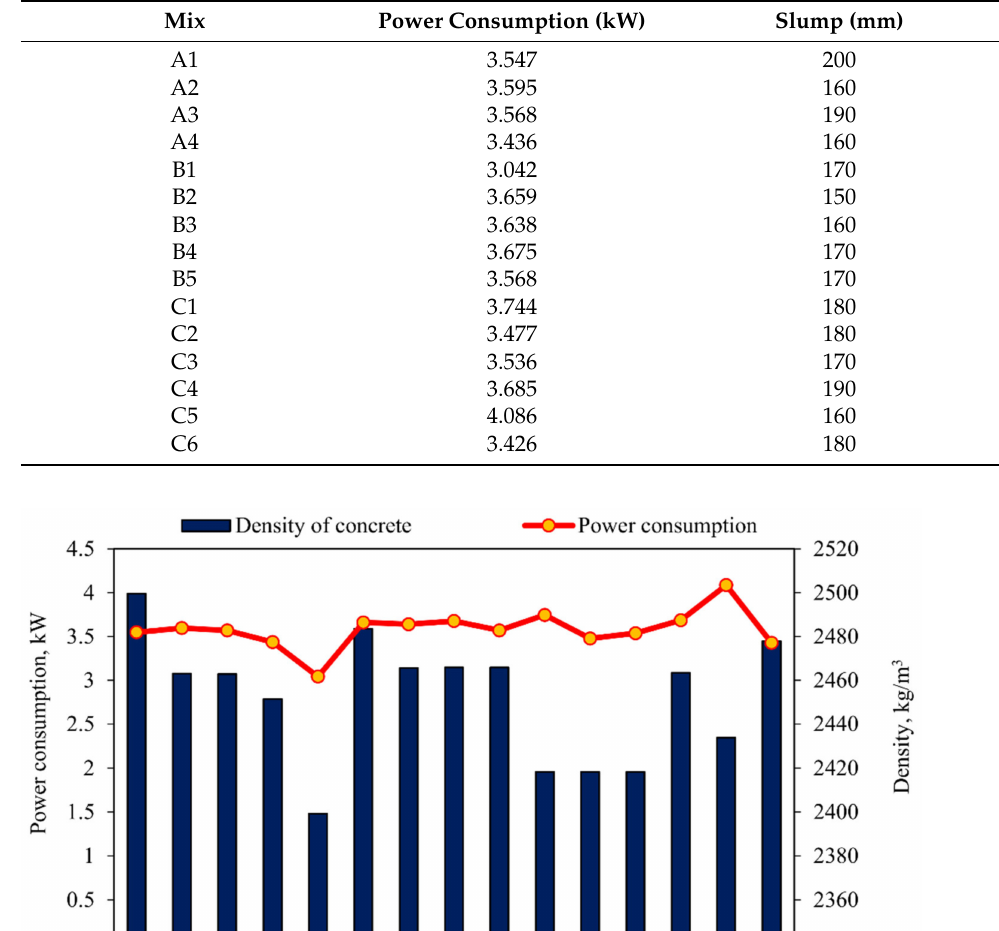
Table 7. The power consumption and slump value measured for different mixes.